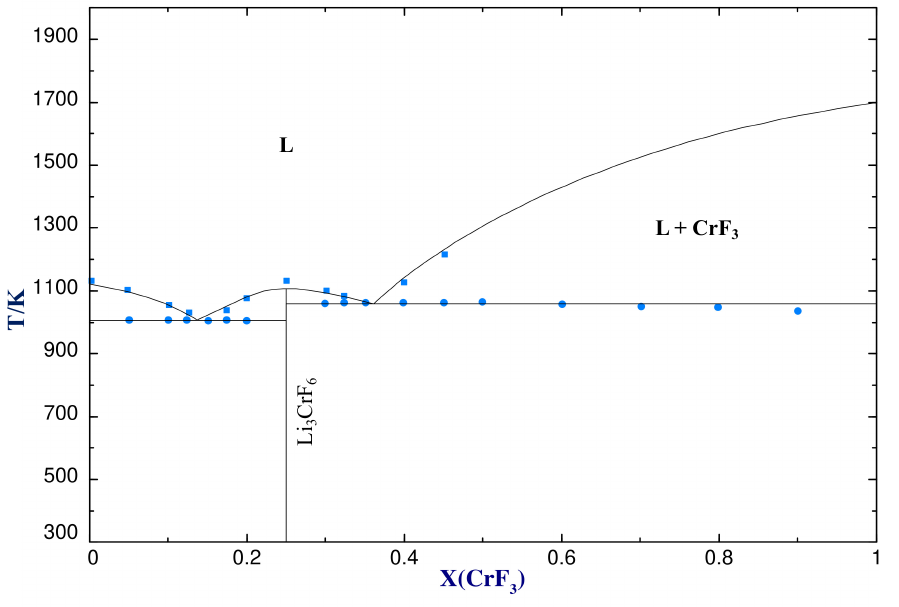
Figure 2. Phase diagram of the LiF–CrF 3 system optimized in this work and comparison with the experimental data provided by de Kozak [15]. Blue squares represent liquidus points and blue circles represent solidus points.